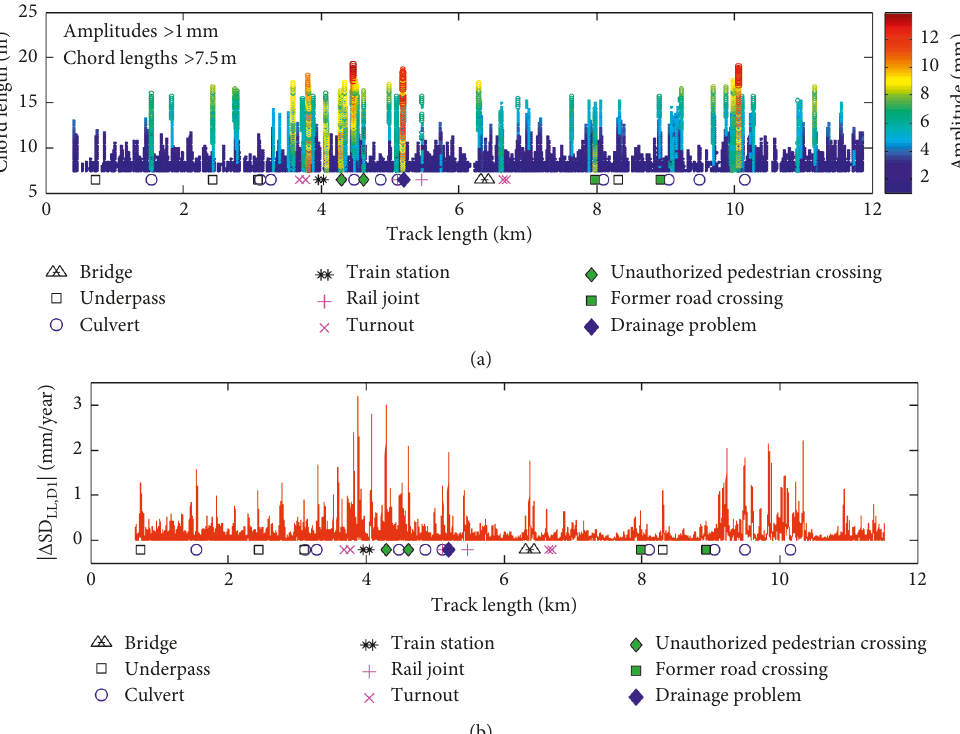
Figure 11: Track degradation: (a) locations associated with higher track degradation; (b) actual degradation in terms of the absolute value of the annual variation of Δ SD LL , D1